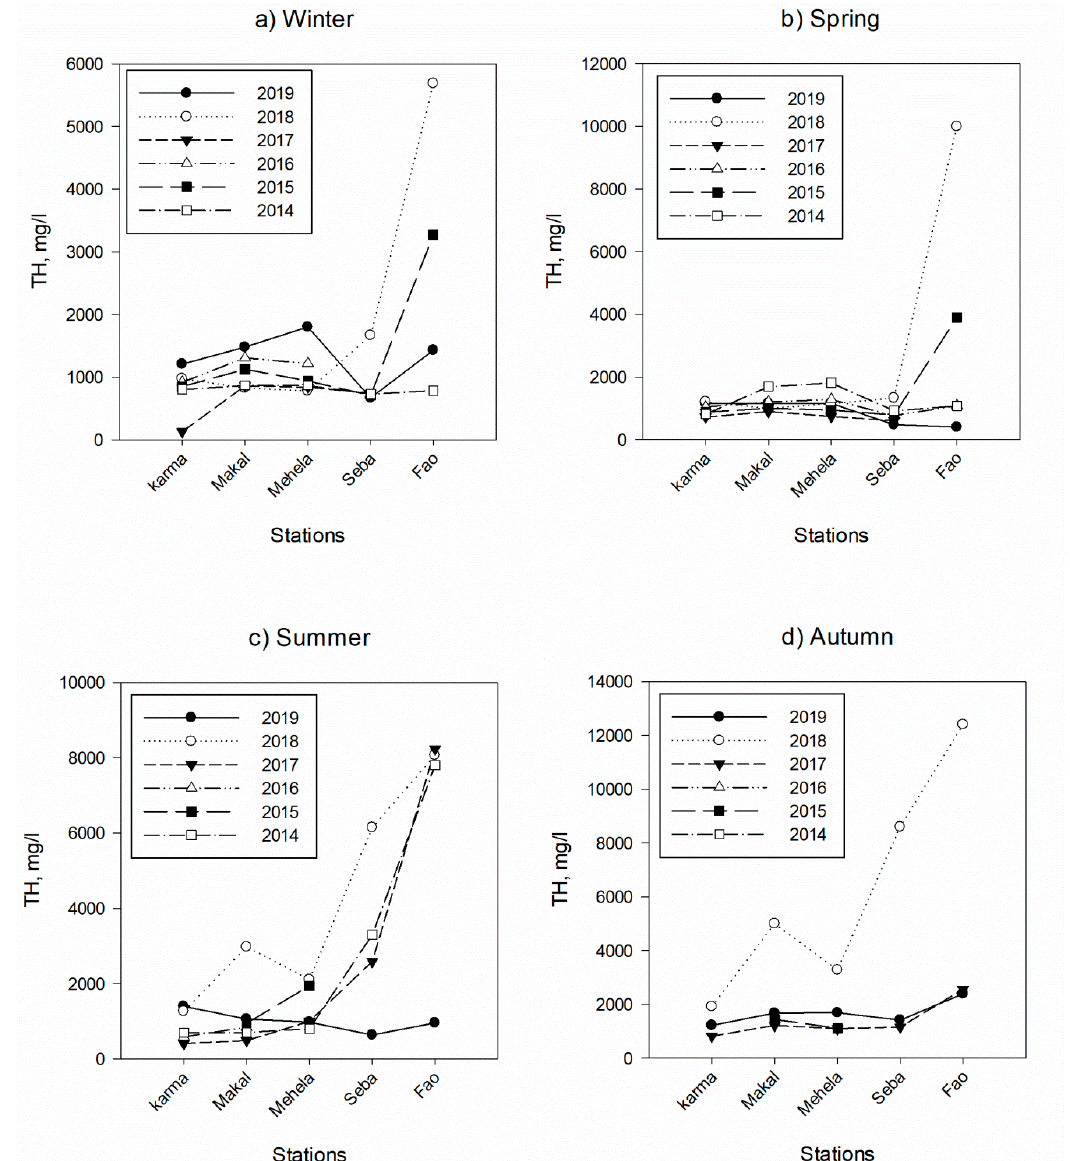
Figure 11. Comparison of TH concentrations of the selected stations for four seasons during the period of 2014 to 2019.